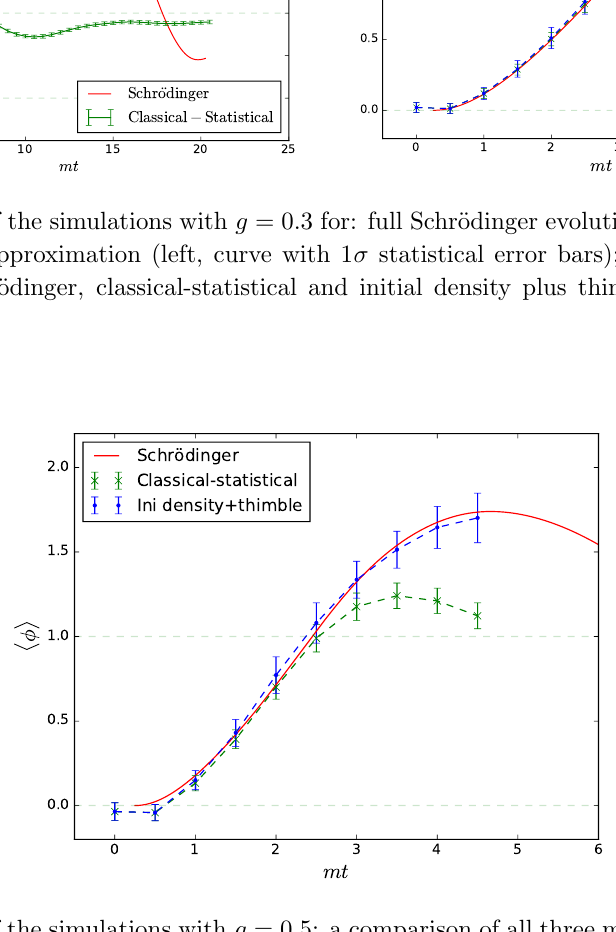
Figure 5 . Results of the simulations with g = 0 : 5: a comparison of all three methods, Schr(cid:127)odinger, classical-statistical and initial density plus